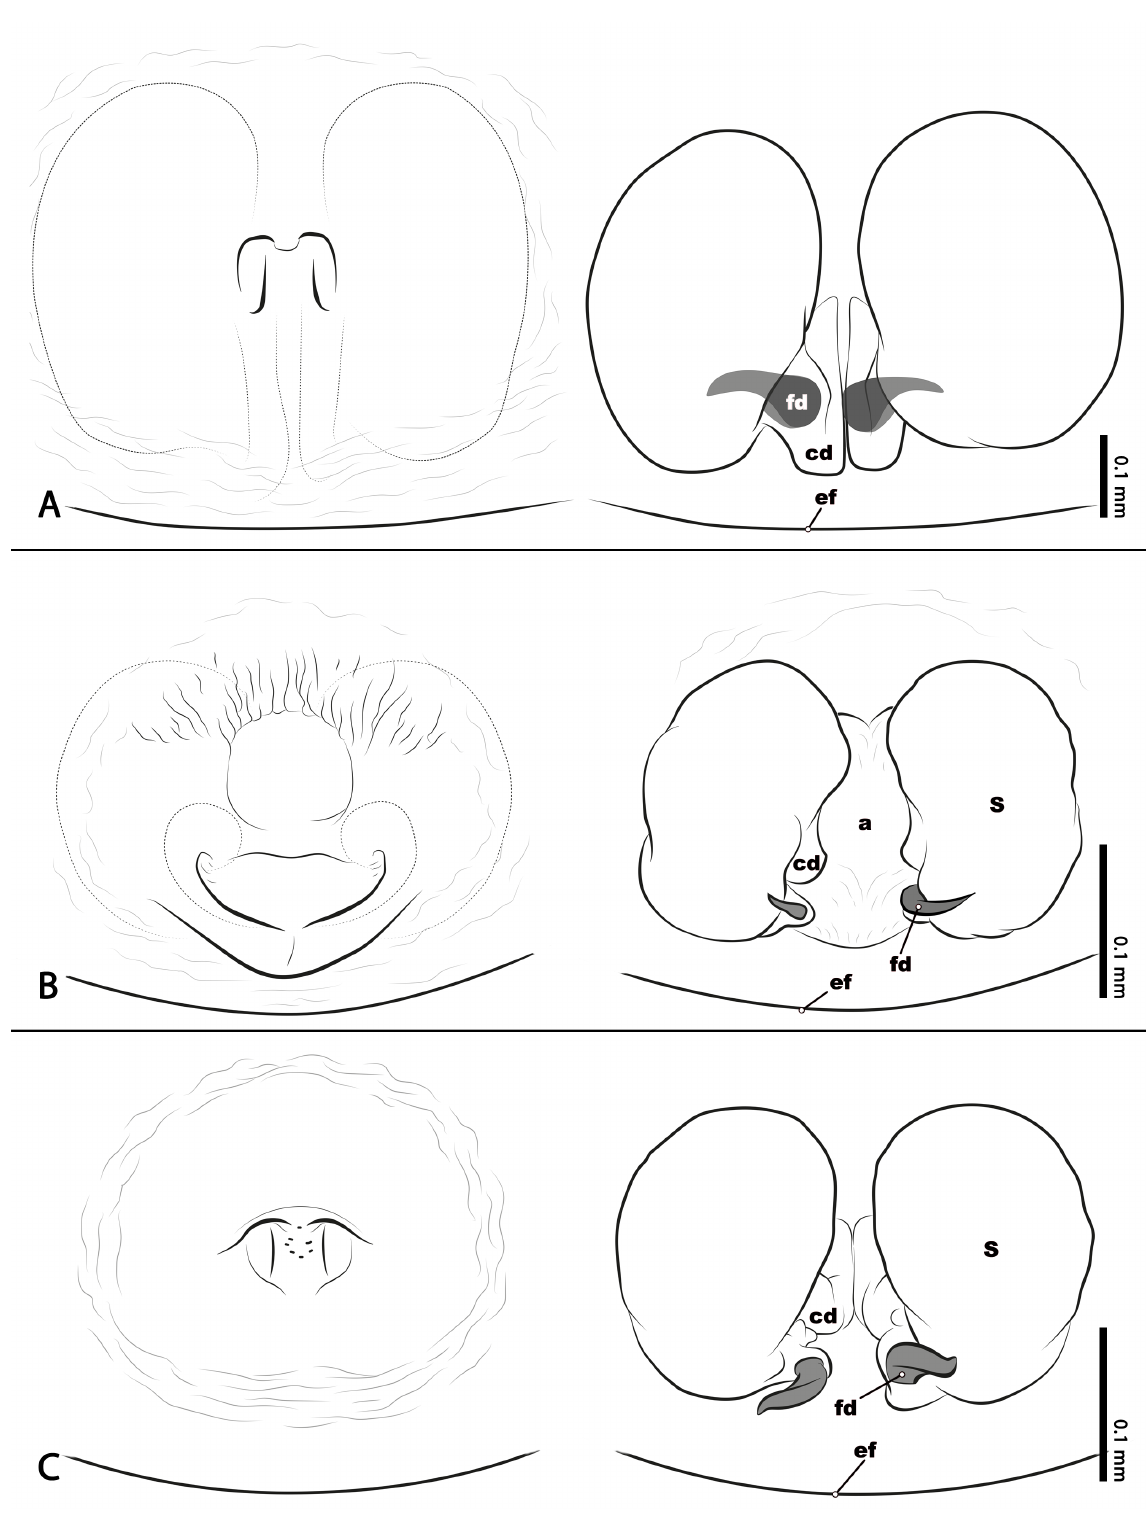
Fig. 21. Illustrations of epigynum in ventral and dorsal view. A . Kryptochroma gigas Machado & Viecelli gen. et sp. nov., holotype (UFMG 4734). B . K. hilaris Machado & Teixeira gen. et sp. nov., holotype (MPEG 13322). C . K. parahybana (Mello-Leitão, 1929) gen. et comb. nov. (MPEG